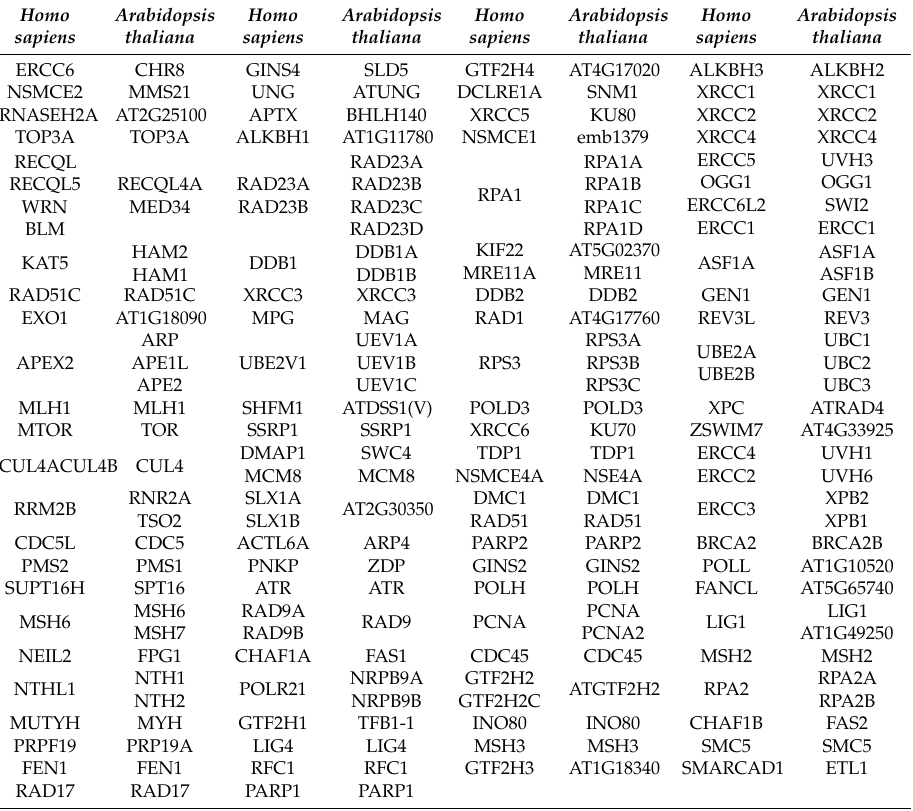
Table 5. DNA repair groups of orthologous genes between Homo sapiens and Arabidopsis thaliana . This table contains only the initial genes from the two organisms that have been already characterized under the GO term ‘DNA repair’ and not the genes that have arisen from this analysis .